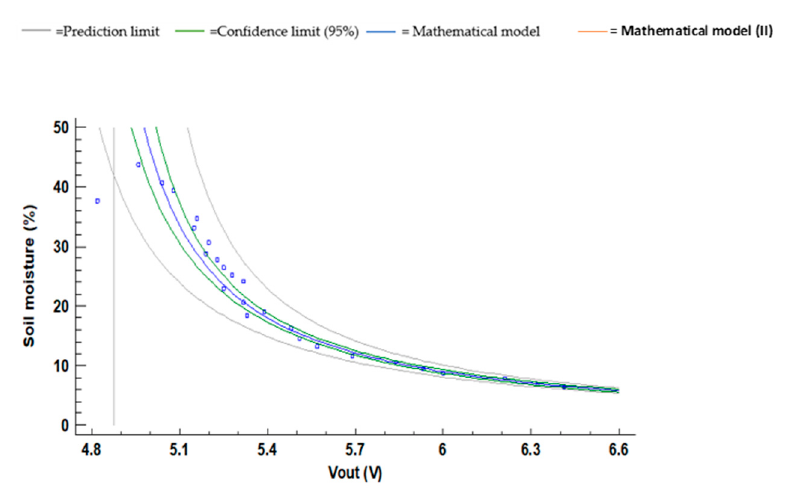
Figure 27. Vout NP2, 490 kHz, one model (I), Equation (20).